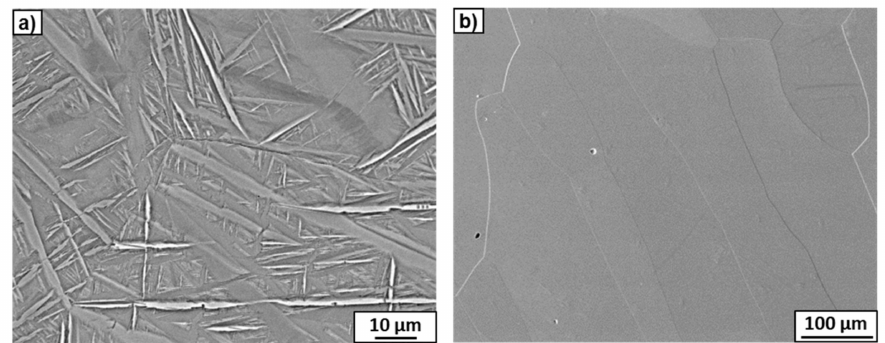
Figure 6. SEM micrographs of the Ti–2wt.% Mo ( a ) and Ti–18wt.% Mo ( b ) alloys after annealing at 1000 ◦ C.